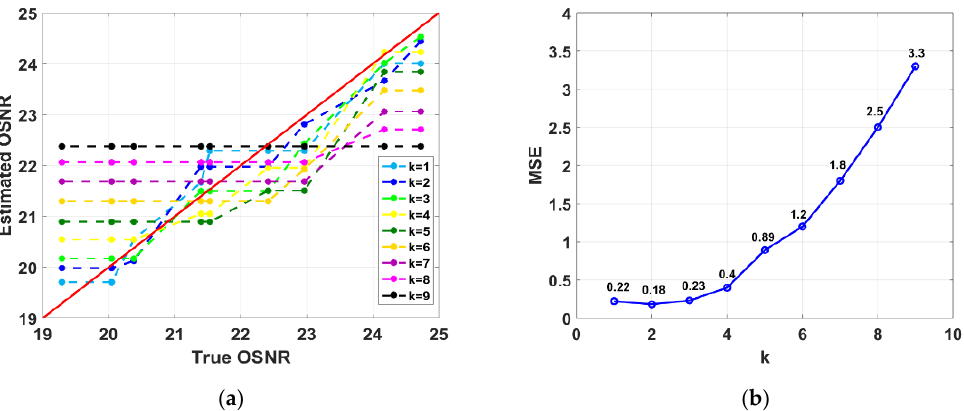
Figure 8. ( a ) Estimated versus true OSNRs with different k values and ( b ) MSE versus k values for 128 QAM (OBTB).